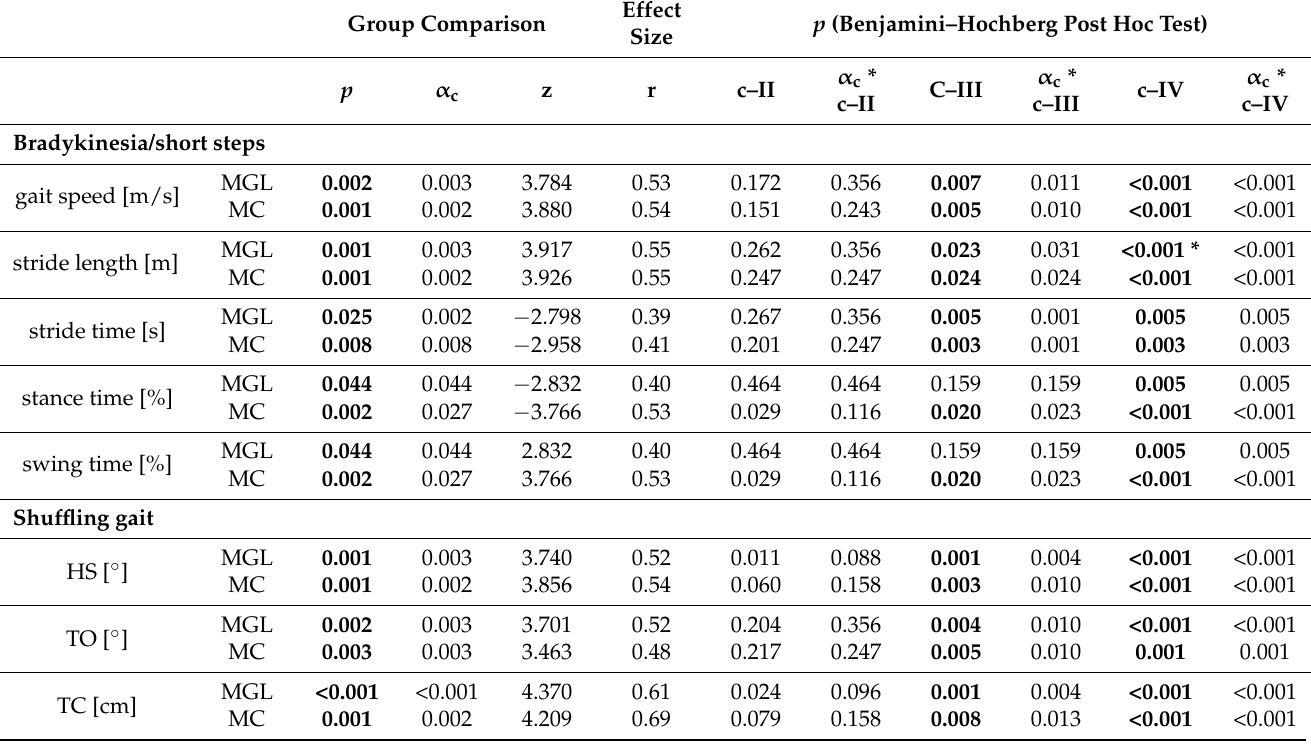
Table 4. Group comparison of MGL and MC and effect size (r) compared between patients subdivided in H&Y stage 2, 3 and 4 (II, III, IV) and control group (c).